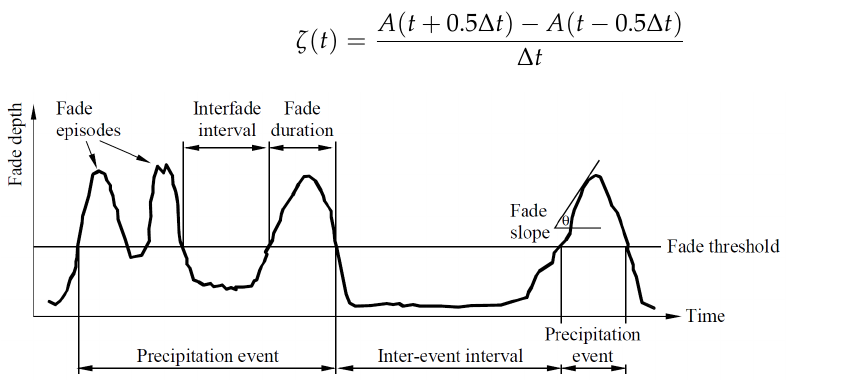
Figure 5. Illustration of the fade slope and fade duration in the received signal level (RSL) time series [98].